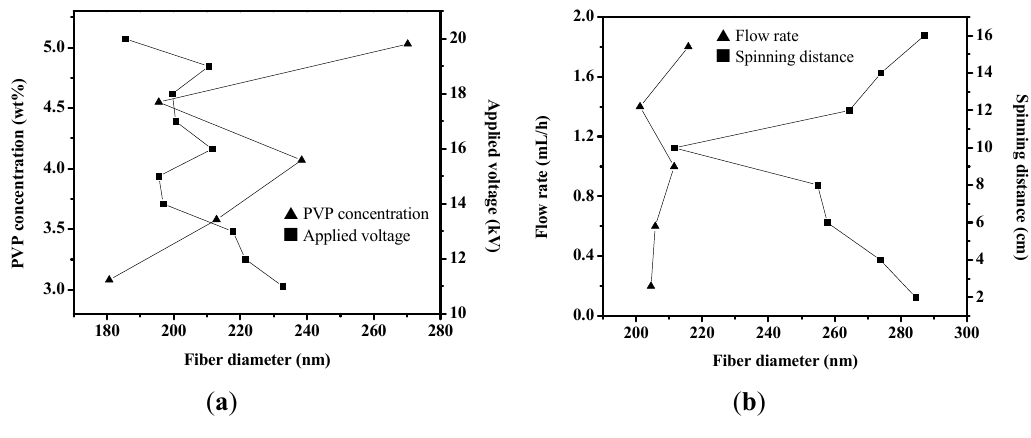
Figure 4. The average diameter tendency chart of PbI 2 /PVP composite fibers produced by changing the working parameters of electrospinning: ( a ) PVP concentration and applied voltage; ( b ) spinning distance and flow rate.